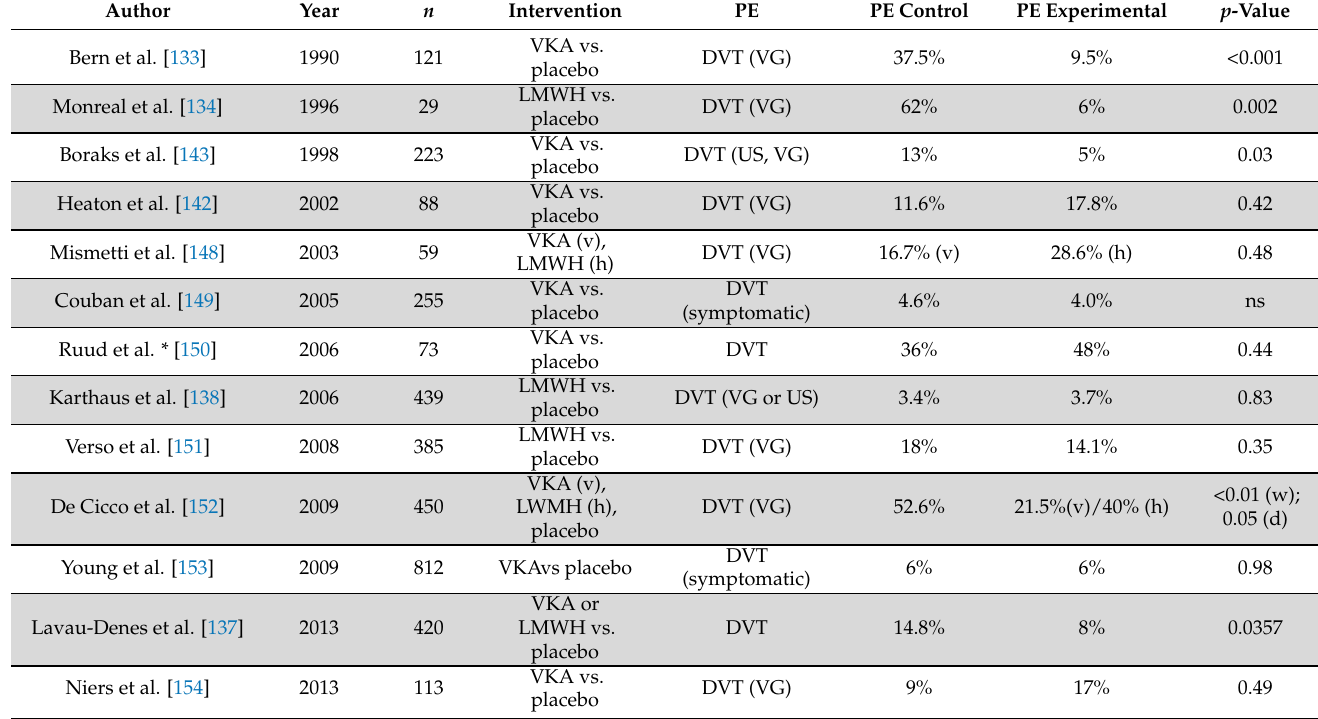
Table 5. Studies for prophylaxis of central venous device-related thrombosis